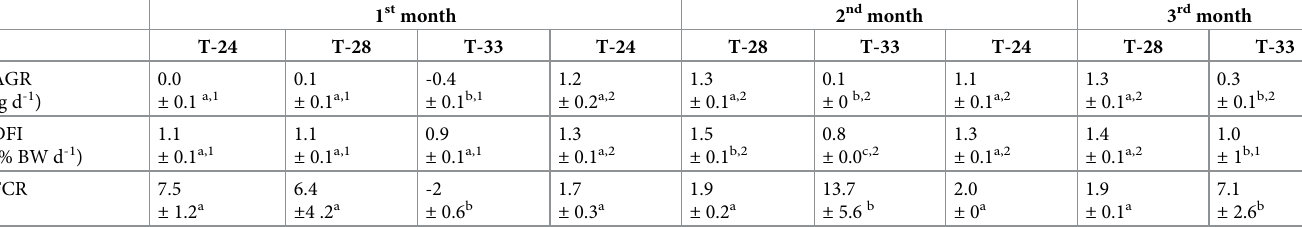
Table 1. Growth performance indicators for E. sea bass reared under three different water temperatures (T-24, T-28, T-33). AGR: Absolute Growth Rate; DFI: Daily Feed Intake; FCR; Feed Conversion Ratio. Values represent the mean and the SD among replicates (N = 3). Statistically significant differences between treatments in each sampling (month) are indicated with different letters and between samplings for each treatment with different numbers.